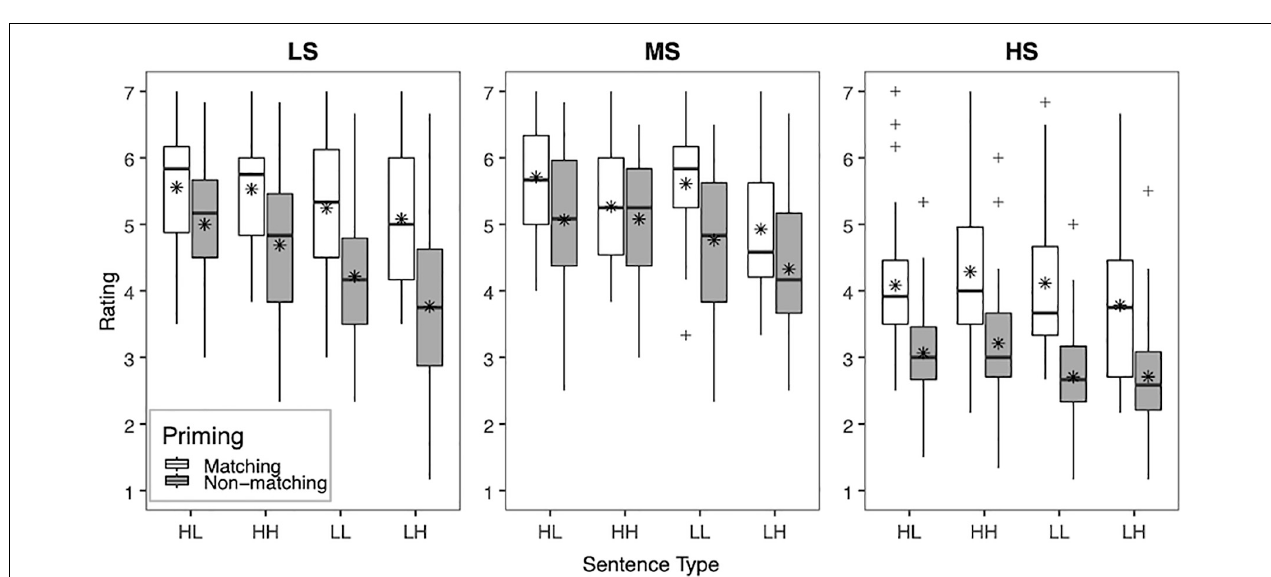
FIGURE 1 | Box plot showing the mean clarity ratings for NH younger adults (YNH). Clarity ratings (1 “very unclear” to 7 “completely clear”) are plotted across all three vocoder conditions (LS, MS, and HS), priming condition (matching and non-matching), and sentence type (HL, HH, LL, and LH). The boxes extend from the lower to the upper quartile (the interquartile range, IQ), the solid midline indicates the median, and the star indicates the mean. The whiskers indicate the highest and lowest values no greater than 1.5 times the IQ, and the plus signs indicate outliers, which are defined as data points larger than 1.5 times the IQ.